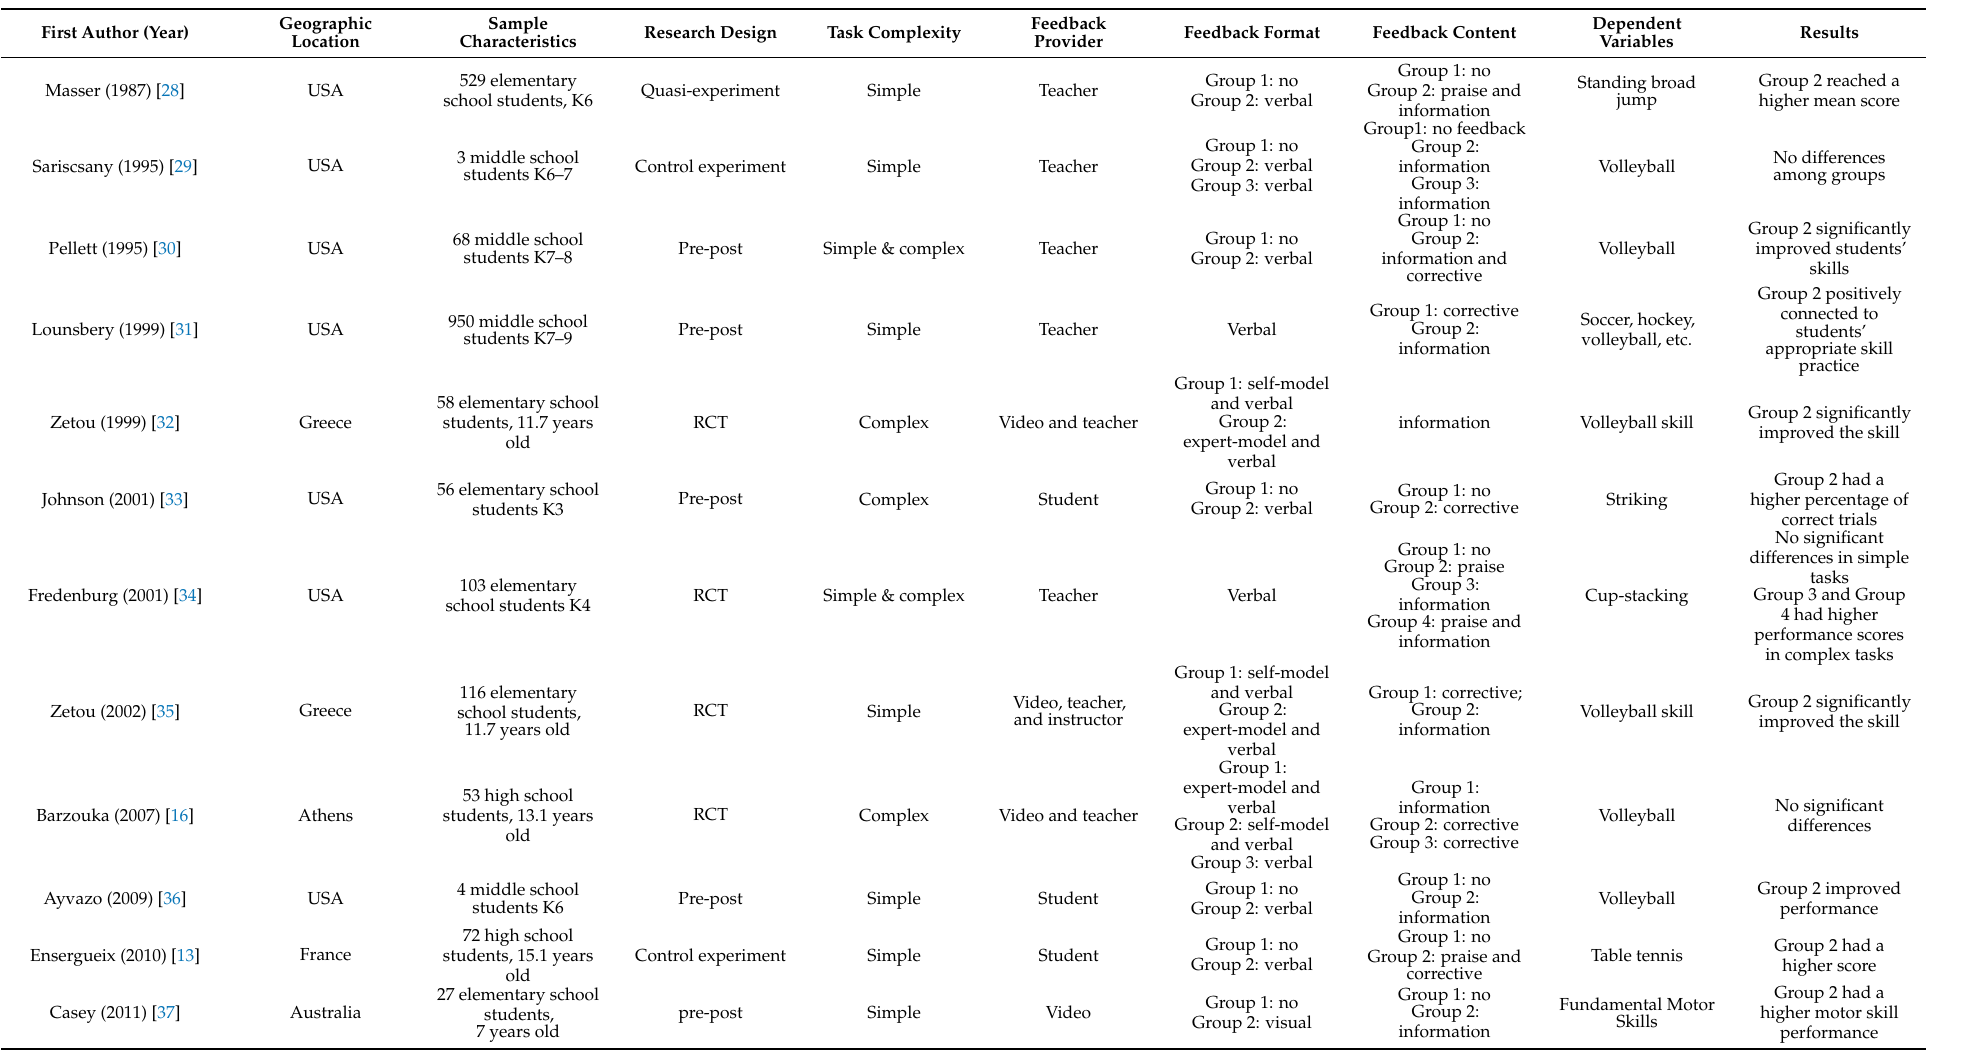
Table 1. Study characteristics of included